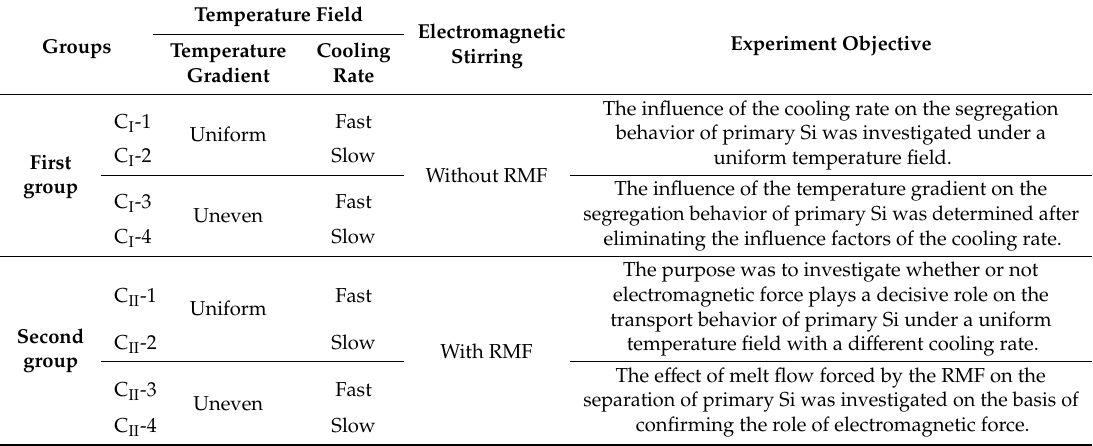
Figure 1. Schematic diagram of the experimental device for each group: ( a ) insulation details of the graphite crucible, ( b ) structural features of the rotating magnetic field (RMF). Table 1. The design details and the logical relationship of each group.